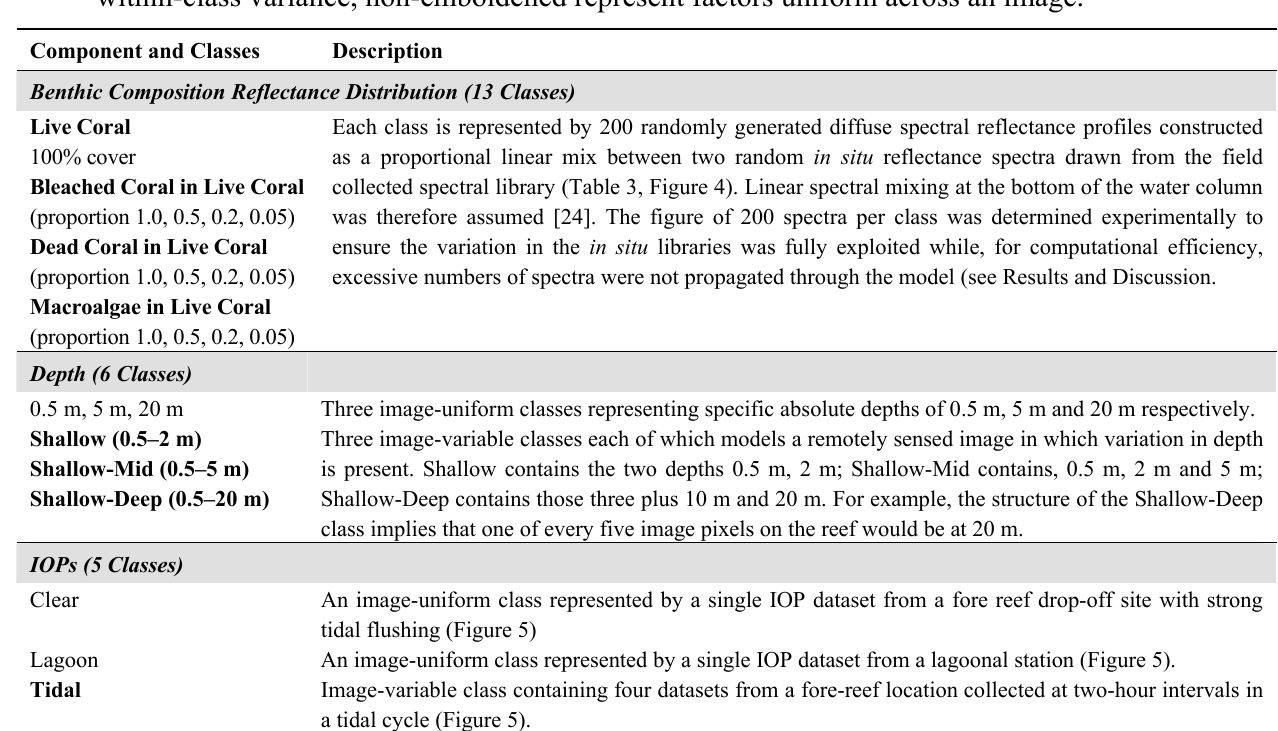
Table 2. Structure of the multi-factor sensitivity analysis. Emboldened classes have within-class variance, non-emboldened represent factors uniform across an